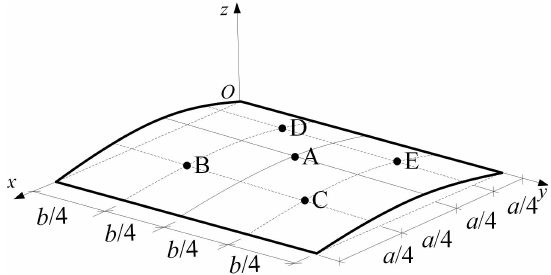
Figure 5: Feature points on membrane surface